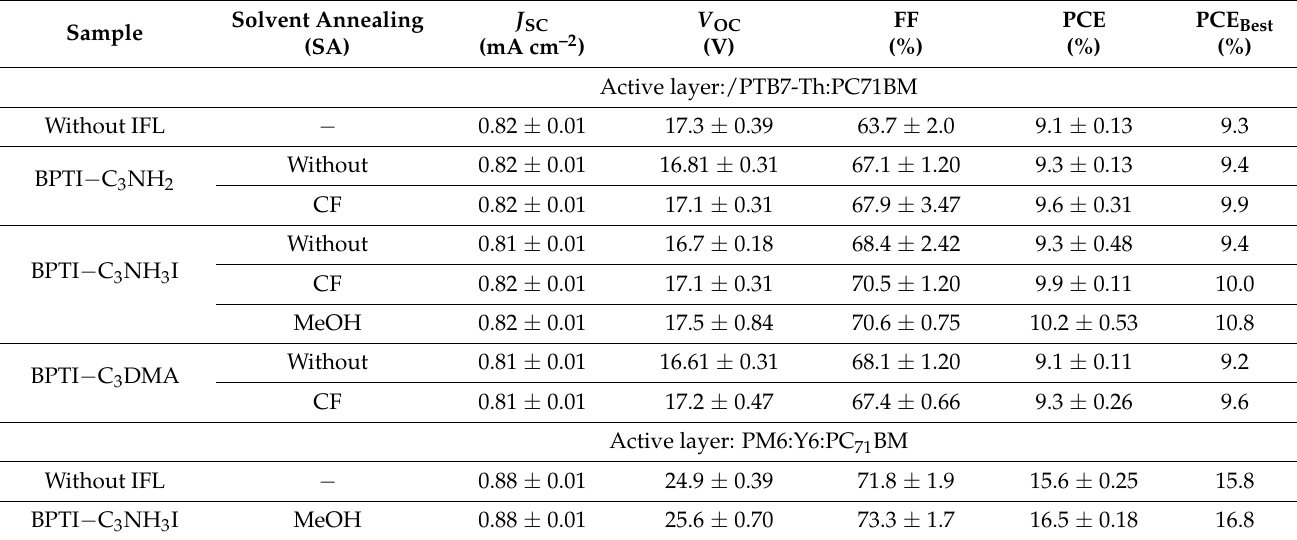
Table 2. J – V properties of the PSC